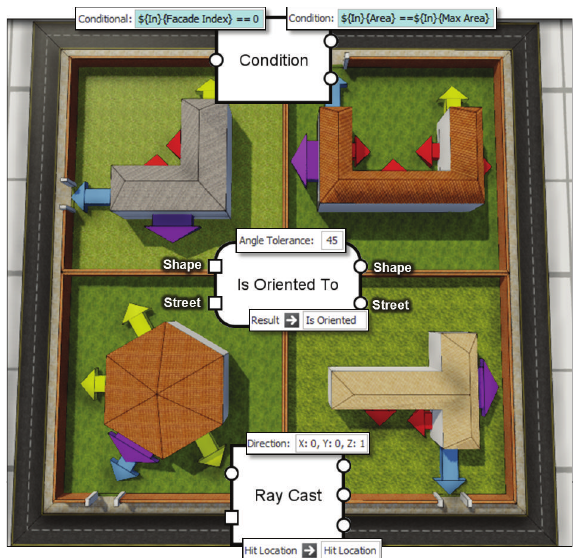
Figure 9: Example of the need to enforce execution scopes. If all the facades are collected without differentiation, only one facade of the whole building set would be selected, instead of one per